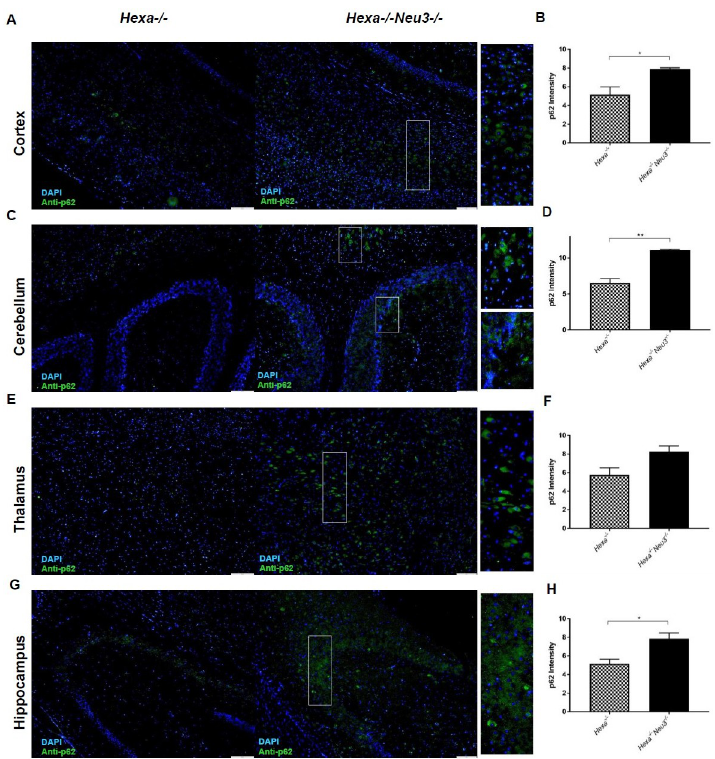
Fig 8. Immunohistochemical analysis images for cortex (A), cerebellum (C), thalamus (E), and hippocampus (G) sections from 5 months old Hexa-/- and Hexa-/-Neu3-/- mice. The sections were stained with anti-p62 antibody (green; Autophagic termination marker) and DAPI (blue; nucleus). Quantification of the relative increase in p62 intensity was represented for cortex (B), cerebellum (D), thalamus (F), and hippocampus (H) Scale bar = 20 μ m. The data are represented as the mean ± S.E.M. One-way ANOVA was used for statistical analysis. ( � p < 0.05, �� p < 0.025, ��� p < 0.01 and ���� p < 0.001).